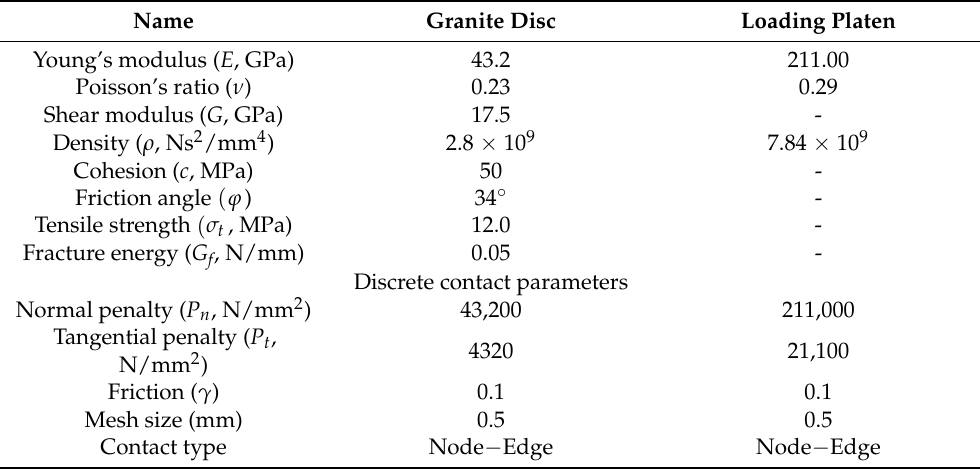
Table 1. Material properties adopted in Brazilian